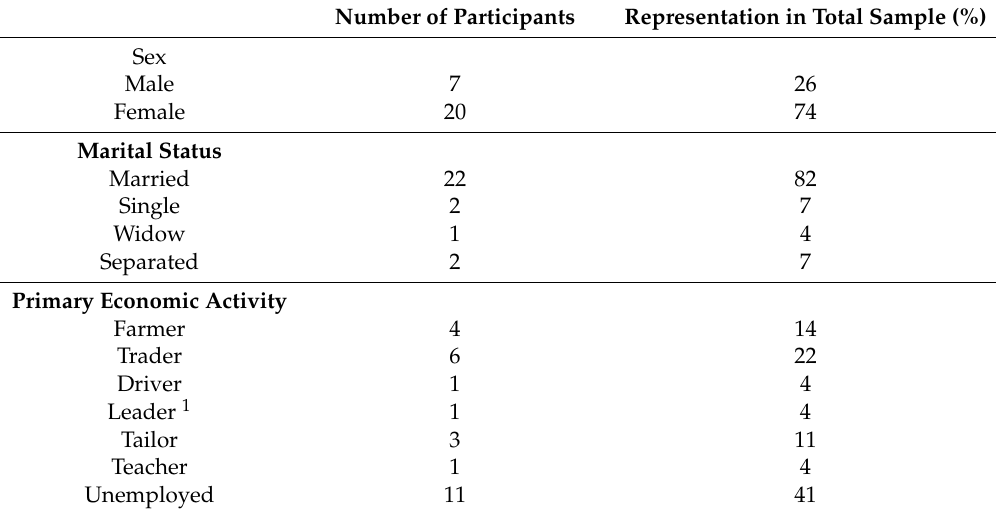
Table 1. Participants’ socioeconomic